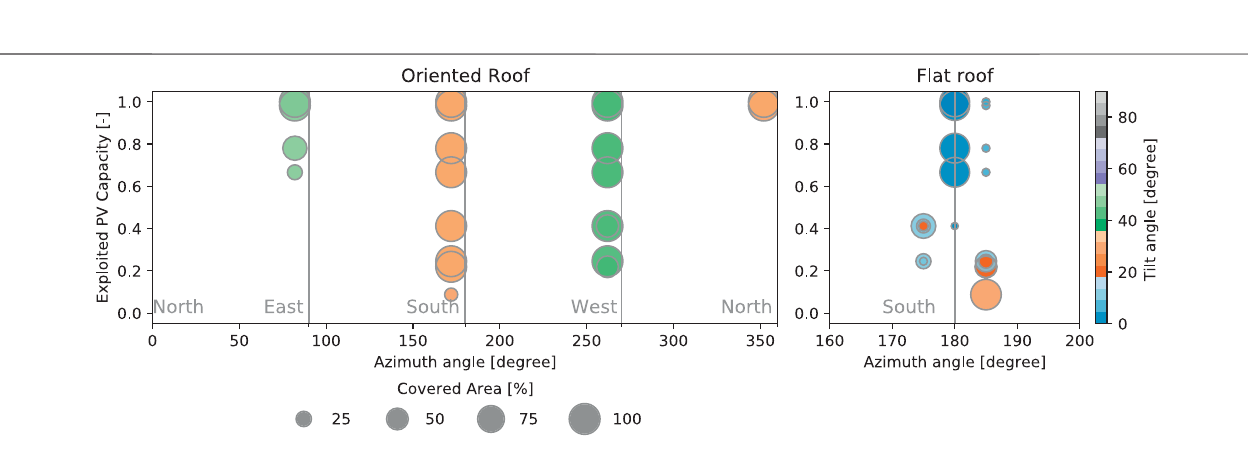
FIGURE 9 | Optimal distribution of PV installation for different